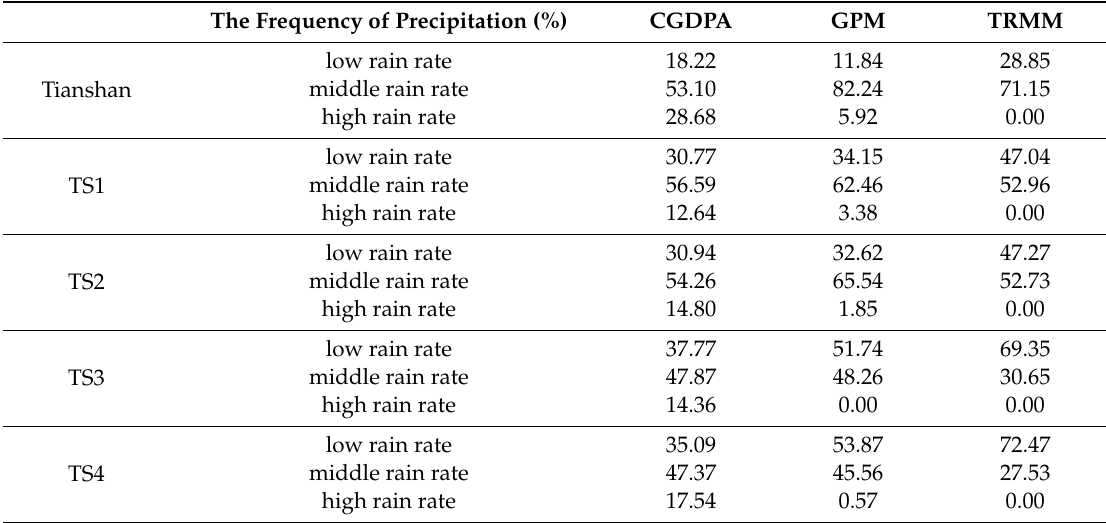
Table 4. The performance of CGDPA, GPM and TRMM in TSM and its subregions. The Frequency of Precipitation